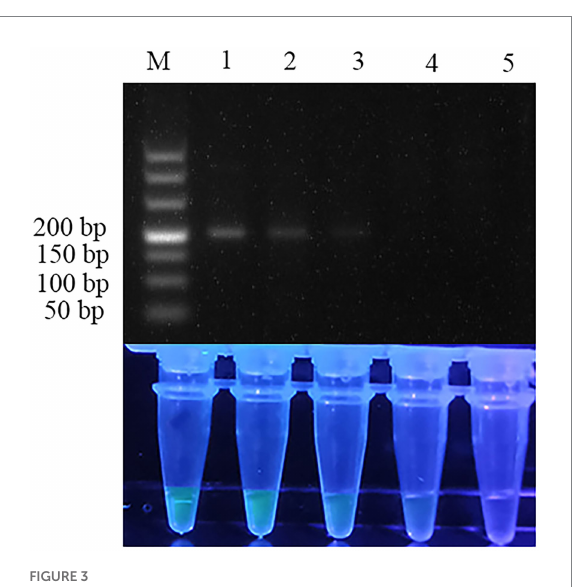
FIGURE 3 Sensitivity of RPA assay. From left to right, the initial templates were 10-fold serially diluted from 1.29 × 10 5 to 1.29 × 10 2 copies per reaction, with no template added as a negative control. Lane M: DL500. Top row: agarose gel electrophoresis images of RPA reactions. Bottom row: Fluorescent assay images corresponding to the RPA reactions. The sensitivity of the gel electrophoresis images and visual detection images of RPA were 10 3 and 10 2 copies per reaction,